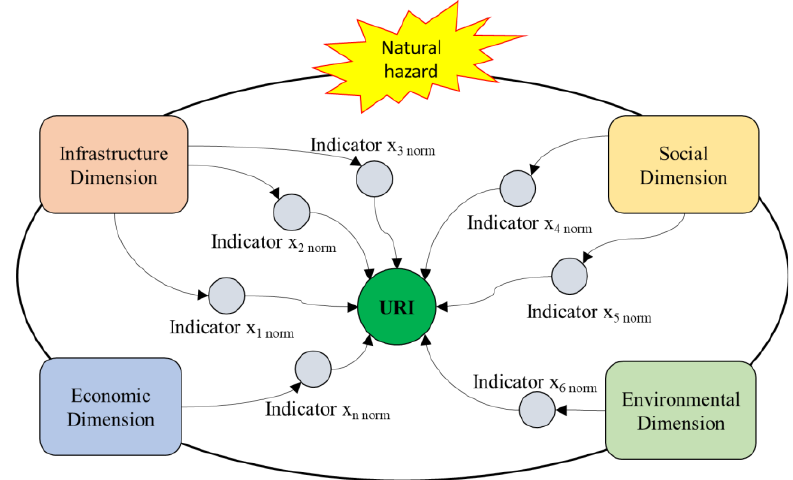
Fig. 3. MCA integration into